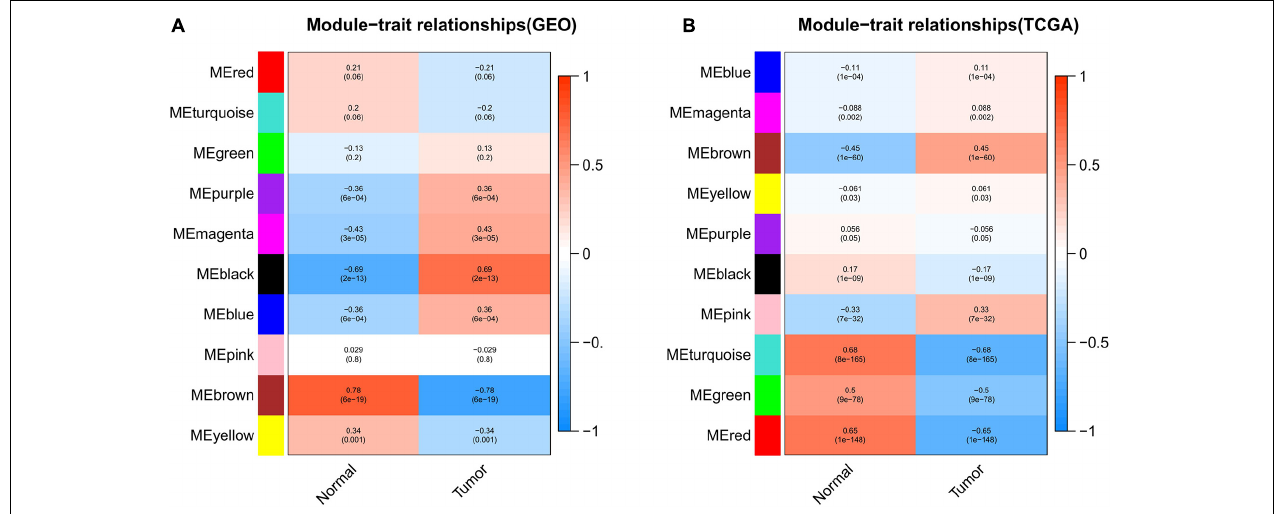
FIGURE 2 | Module-trait relationships in the (A) GEO and (B) TCGA. Each row represents a gene module. Each column corresponds to the clinical characteristics of the cancer. Each grid contains the correlation coefficient and P -value of the gene module.